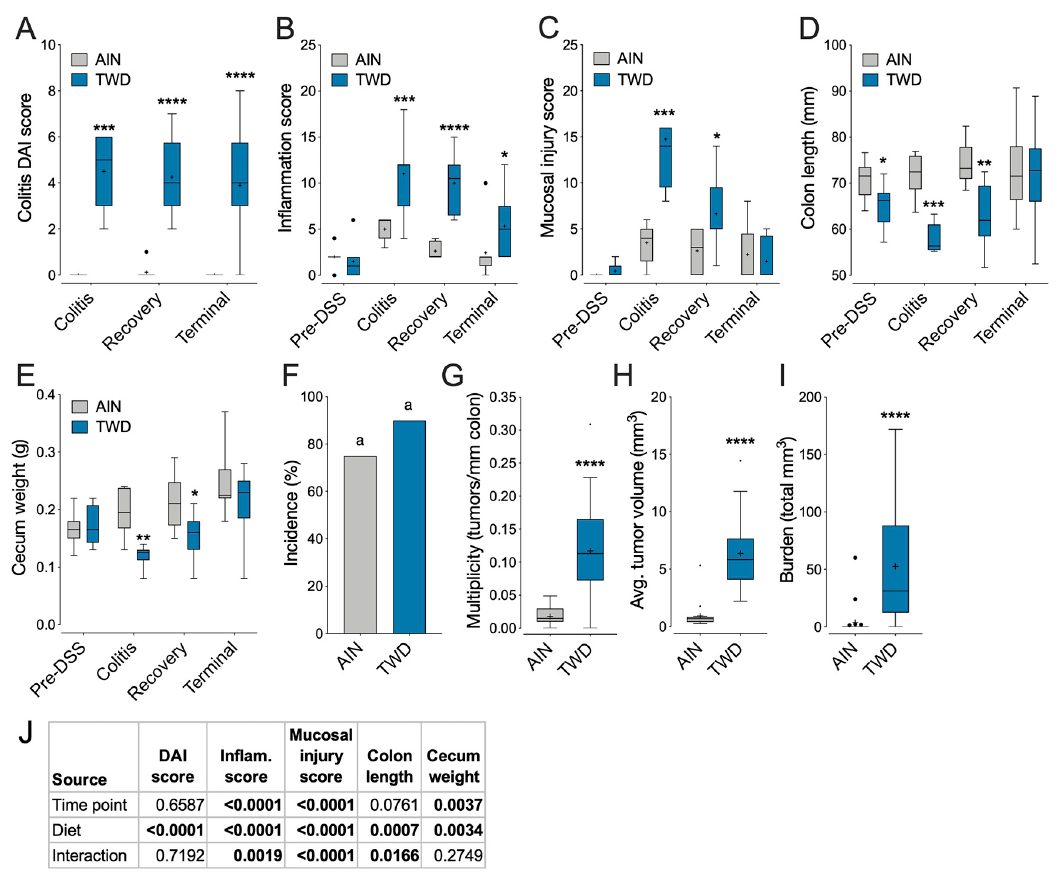
Figure 4. Consumption of TWD enhanced symptoms of colitis, colon inflammation and mucosa injury while also delaying recovery from gut injury caused by 1% DSS treatment (Experiment D). C57BL6/J male mice were fed AIN or TWD diets and provided DSS for 10 days to trigger colon inflammation. ( A ) DAI score ( n = 8 at colitis and recovery, n = 20-23 at terminal time point). ( B , C ) Histopathology inflammation score ( B ) or mucosal injury score ( n = 6 to 9). ( D , E ) Colon length ( D ) and cecum weight ( E ) ( n = 7-8 for pre-DSS, colitis and recovery; n = 20-23 at terminal time point). ( F–I ) Colon tumorigenesis outcomes, including incidence ( F ), multiplicity ( G ), average tumor volume per mouse ( H ) and burden as the total tumor volume ( I ). Data in all panels (except F) are shown as Tukey box plots (box, 25th to 75th percentiles; whiskers, 1.5 IQR; + , mean). * p < 0.05; ** p < 0.01; *** p < 0.001; **** p < 0.0001 for TWD compared to AIN diet as determined by linear mixed model analyses for diet by time point with LS Means Student’s t- test post-hoc test between AIN and TWD diet groups. ( J ) Main effect p -values for diet, DSS treatment, sex and all possible interactions are shown for DAI score, inflammation score, mucosal injury score, colon length and cecum weight.